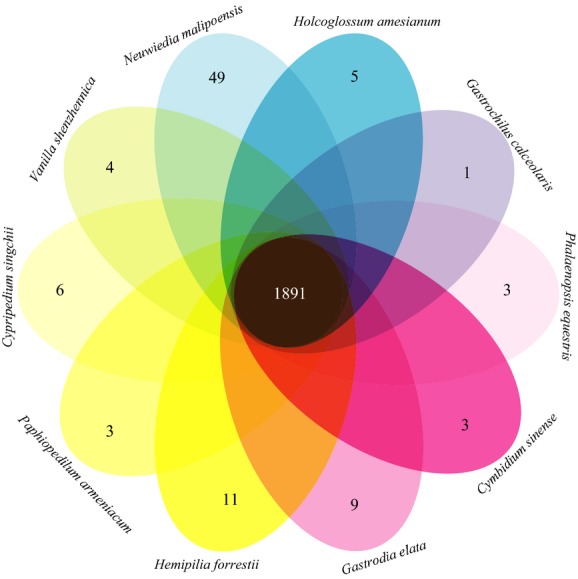
Venn diagram of the shared orthologous gene families among 10 orchids. In total, 1891 gene families (containing 315 single-copy gene families) were shared among 10 orchids. The numbers of the specific gene cluster of each species are shown in ellipses.